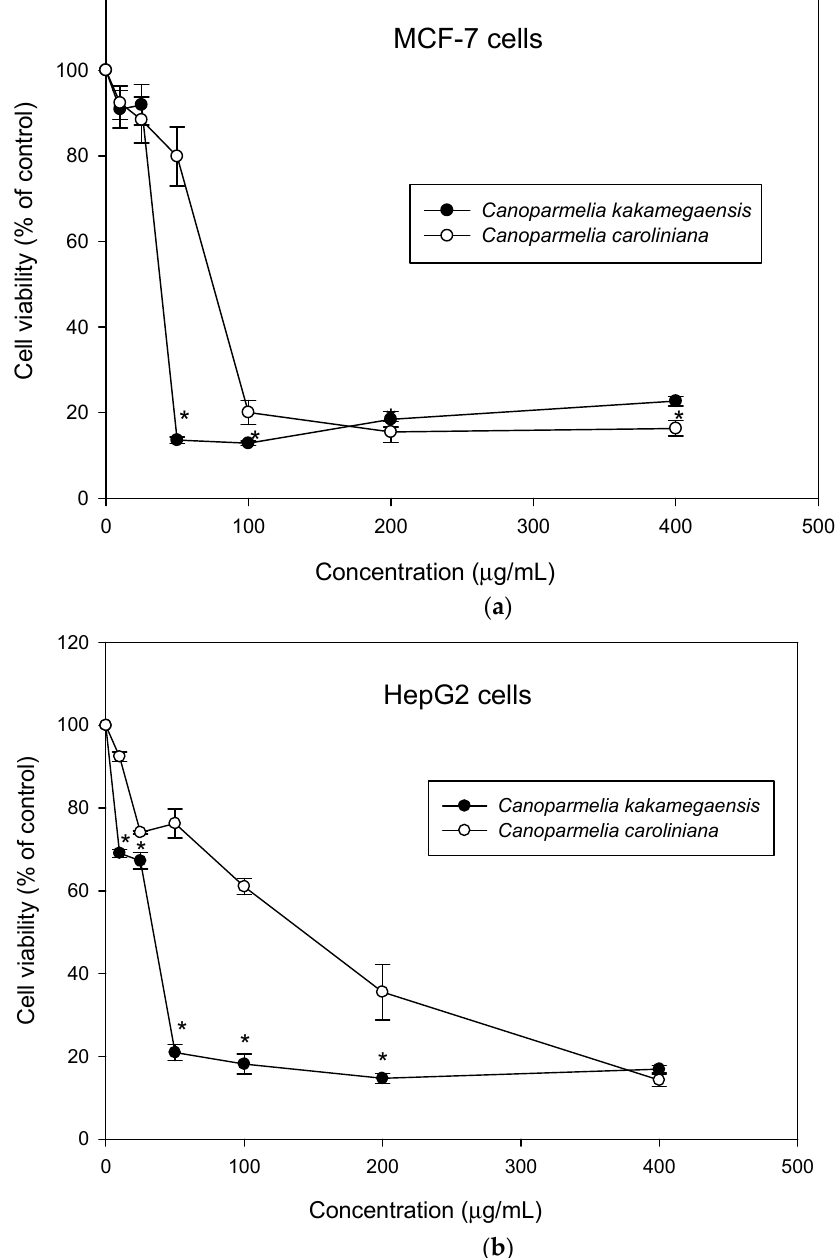
Figure 3. Effect on cell viability ( a ) MCF-7 cells and ( b ) HepG2 cells treated with different concentrations of extracts of Canoparmelia kakamegaensis and Canoparmelia caroliniana for 24 h using MTT assay. Values are expressed as mean ± standard deviation. * Indicates statistically significant differences ( 𝑝 < 0.05) between lichen extracts.